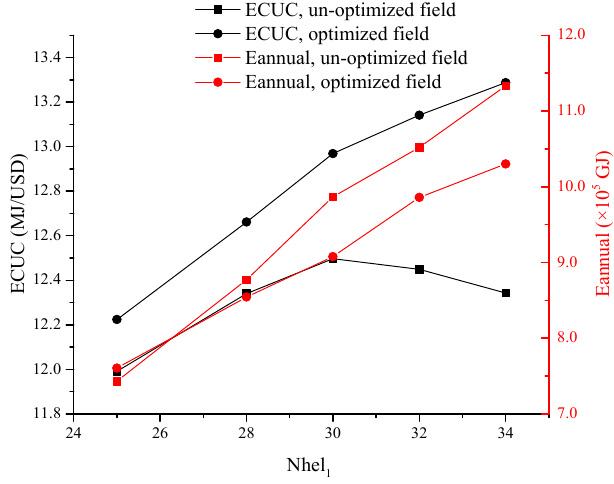
Figure 6. Effect of Nhel 1 on the energy collected of unit cost and annual energy collected.